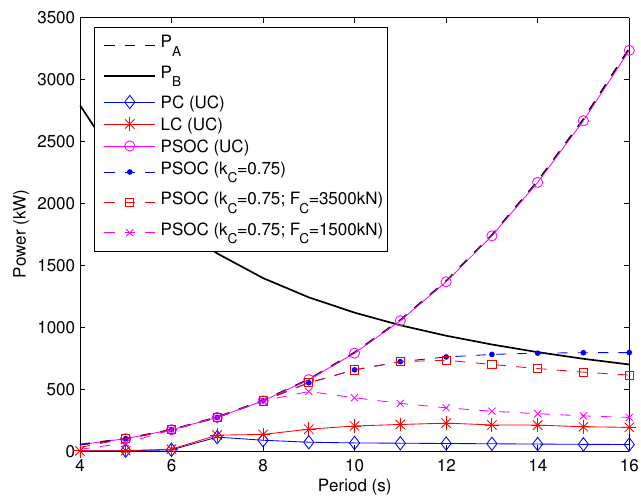
Figure 5. Two upper bounds ( P A and P B ) for the power that can be absorbed from a sinusoidal wave with H = 1.8m and power absorbed by the cylinder ( r = 5m; d = 10m) when different control strategies and constraints are employed for